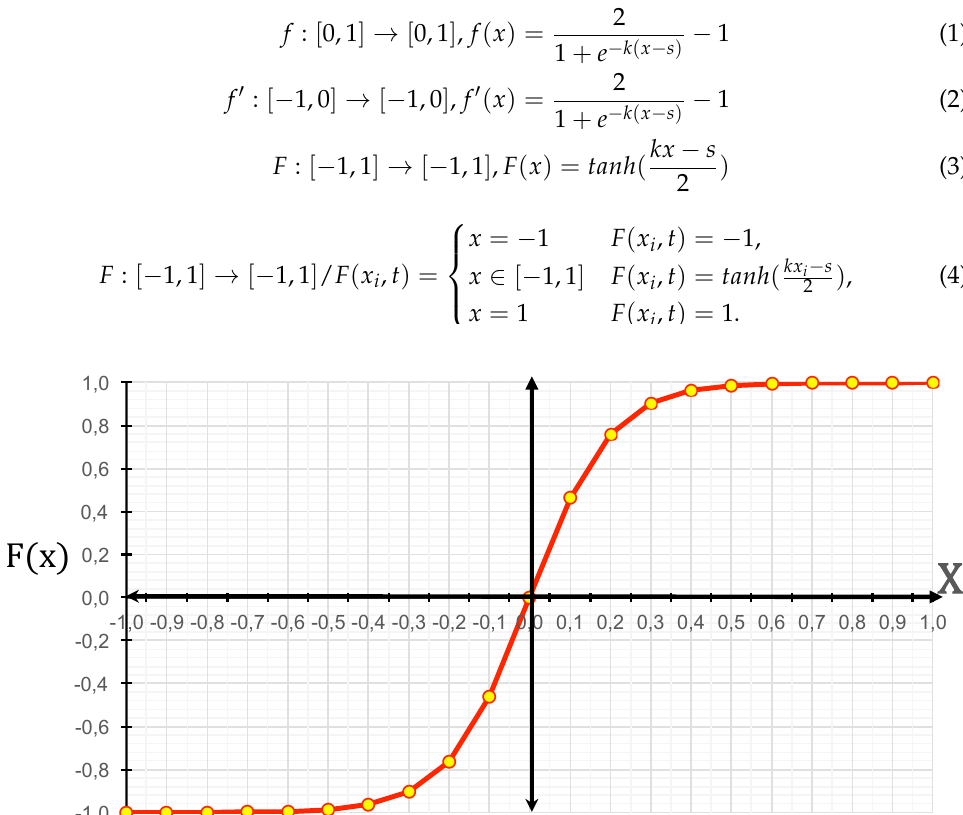
Figure 2. A sigmoid membership function on [ − 1,1 ] −→ [ − 1,1 ]